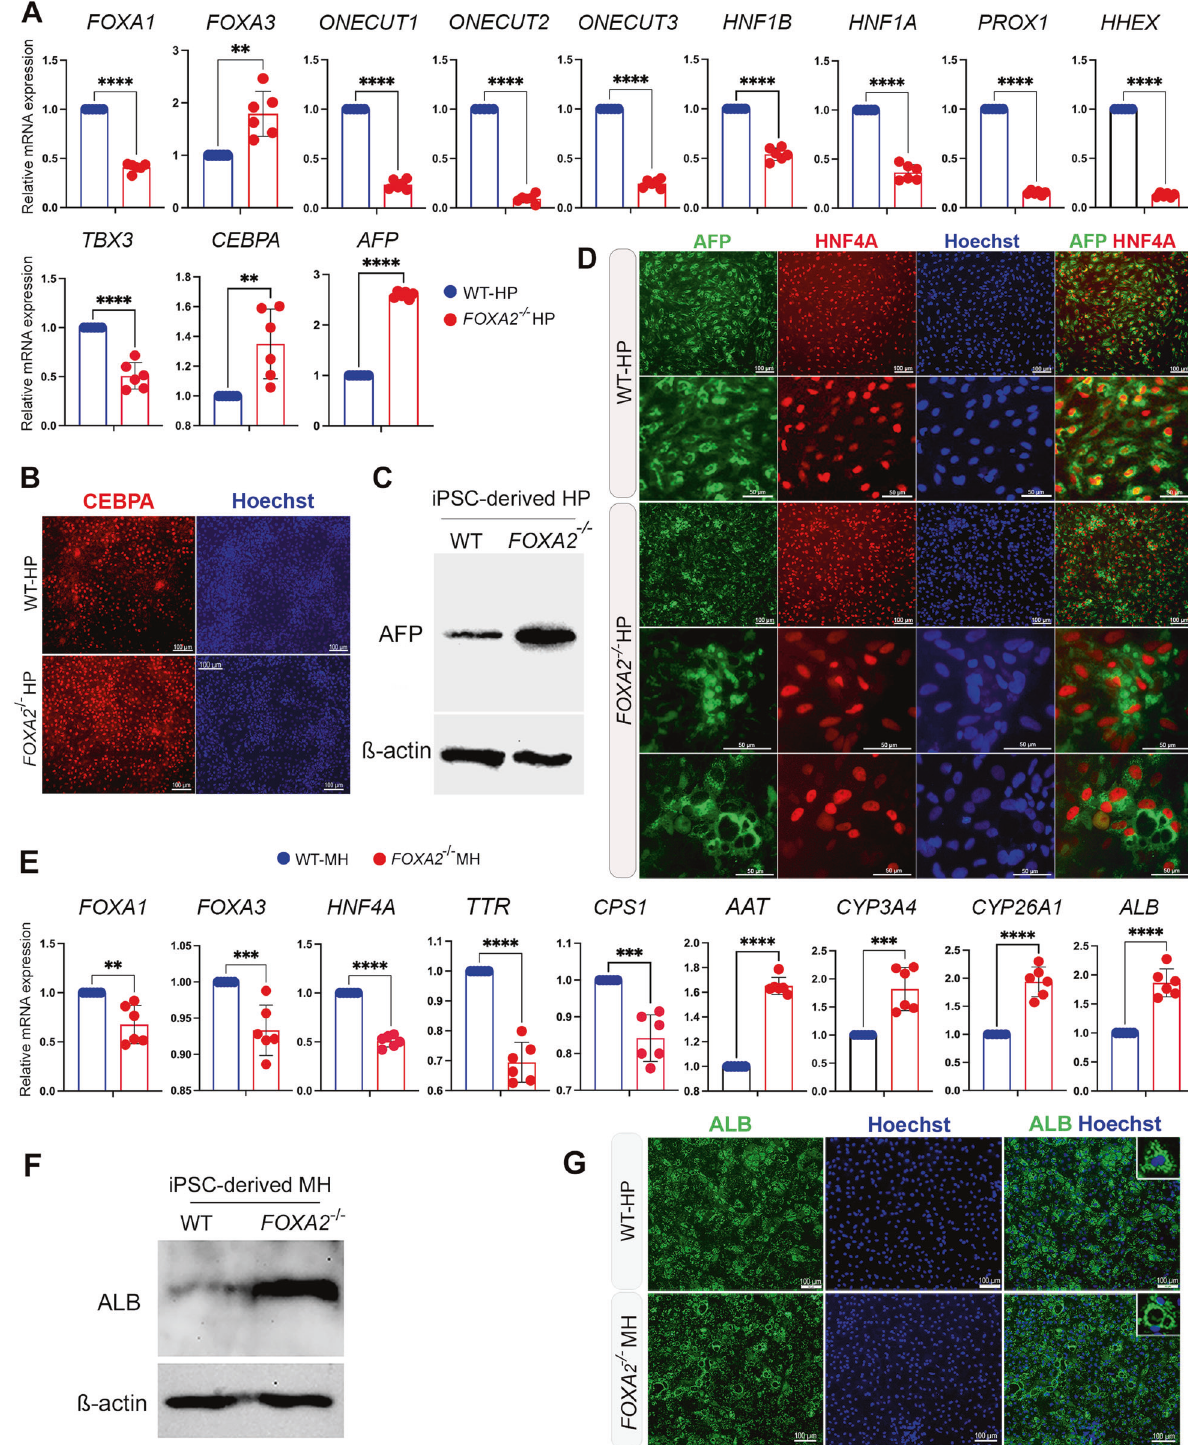
Fig. 2 Effect of FOXA2 knockout on iPSC-derived hepatocytes. A RT-qPCR analysis showing the mRNA expression of hepatic progenitor (HP) markers , FOXA1 , FOXA3 , ONECUT1 , ONECUT2 , ONECUT3 , HNF1B , HNF1A , PROX1 , HHEX , TBX3, CEBPA , and AFP in FOXA2 − / − HP relative to wild type (WT) controls ( n = 6). B Immuno fl uorescence images showing the expression of CEBPA in HP derived from WT-iPSCs and FOXA2 − / − iPSCs. C Western blot analysis showing the upregulation of AFP in HP lacking FOXA2 compared to WT controls. D Immuno fl uorescence analysis showing co-expression of AFP and HNF4A in HP derived from WT-iPSCs and FOXA2 − / − iPSCs. Note the pattern of AFP expression in FOXA2 − / − HP. E RT-qPCR analysis showing the mRNA expression of mature hepatocyte (MH) markers , FOXA1 , FOXA3 , HNF4A , AAT , TTR , CPS1, CYP3A4 , CYP26A1 , and ALB in FOXA2 − / − MH relative to WT controls ( n = 6). F Western blotting showing the upregulation of ALB protein in FOXA2 − / − MH compared to WT. G Immuno fl uorescence showing ALB protein expression in FOXA2 − / − MH compared to WT controls. Note the ALB distribution around cytoplasmic vacuoles. Nuclei were counterstained with Hoechst. The data are presented as mean ± SD. * p < 0.05, ** p < 0.01, *** p < 0.001. Cell Death and Disease (2022)